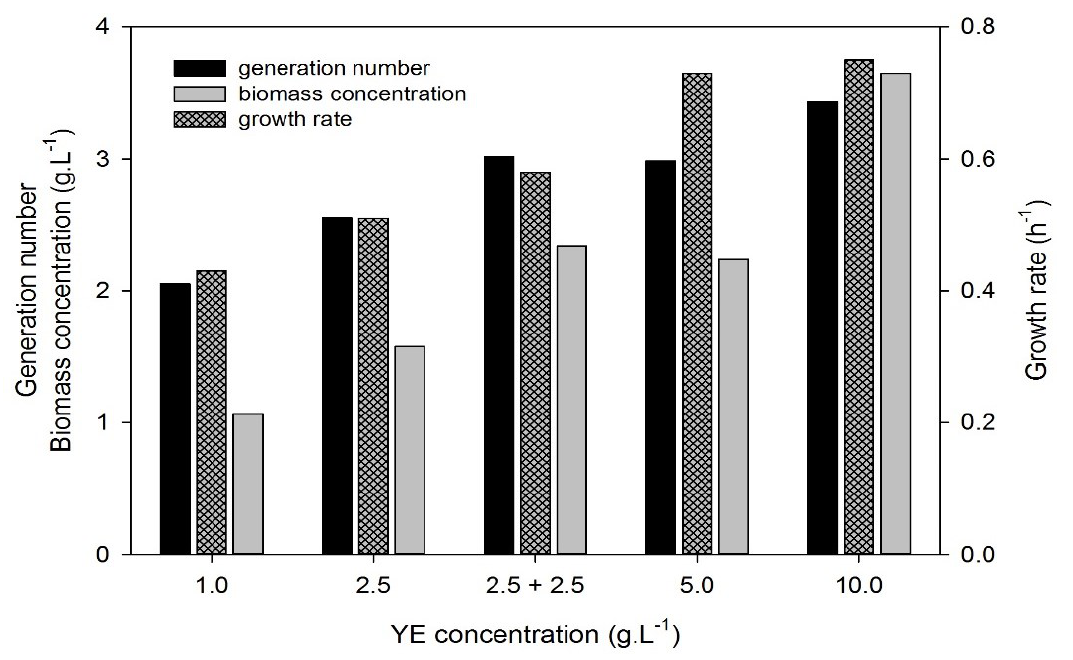
Figure 2 Effect of yeast extract concentration on the culture of Deinococcus geothermalis DSM-11302 in Complex Medium Glucose in terms of number of generations, biomass concentration and growth rate. 2.5 + 2.5 means that 2.5 g·L −1 yeast extract (YE) were in the initial medium and a supplementary pulse of 2.5 g·L −1 YE was made when the culture reached the stationary